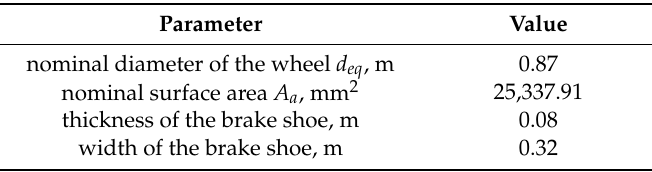
Table 1. Dimensions of the braking system.